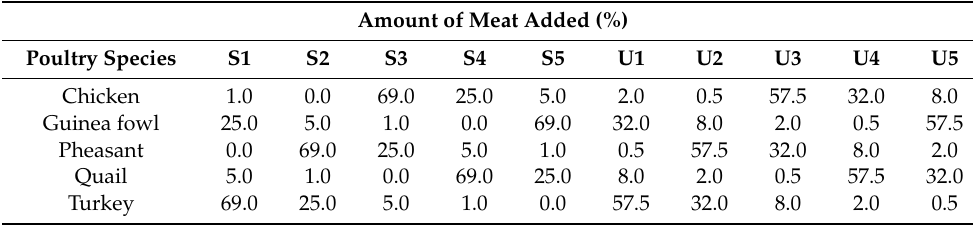
Table 1. Composition of standard (S1-5) and unknown emulsified type sausages